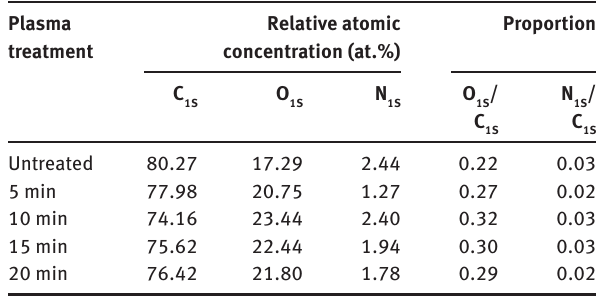
Table 1: The surface composition of the PI fibers under different treatment